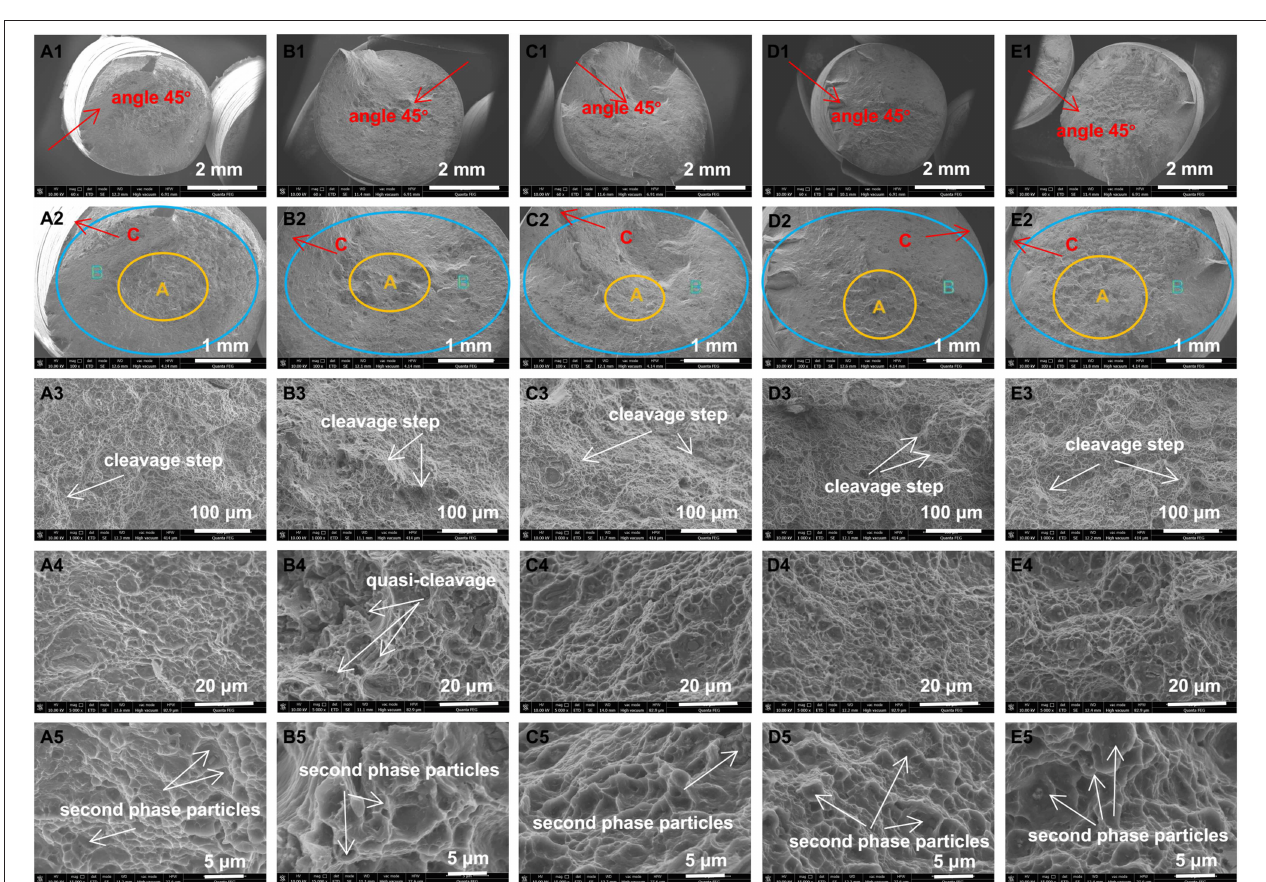
FIGURE 9 | Fracture surface morphologies of as-extruded MZC (A) , MZC0.3Mn (B) , MZC0.5Mn (C) , MZC0.7Mn (D) , and MZC0.9Mn (E) alloys.